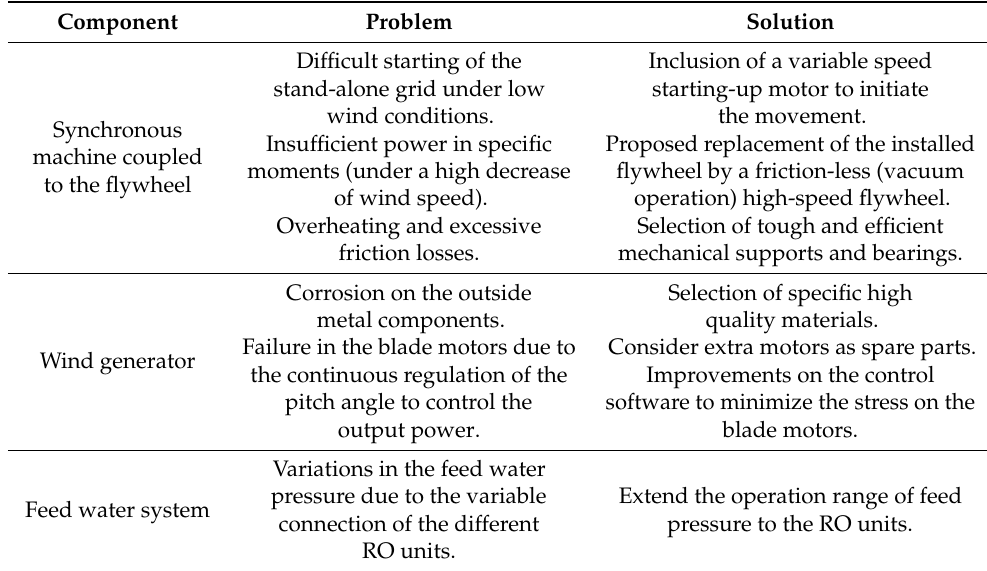
Table 8. Main operational problems after testing a wind-powered SWRO